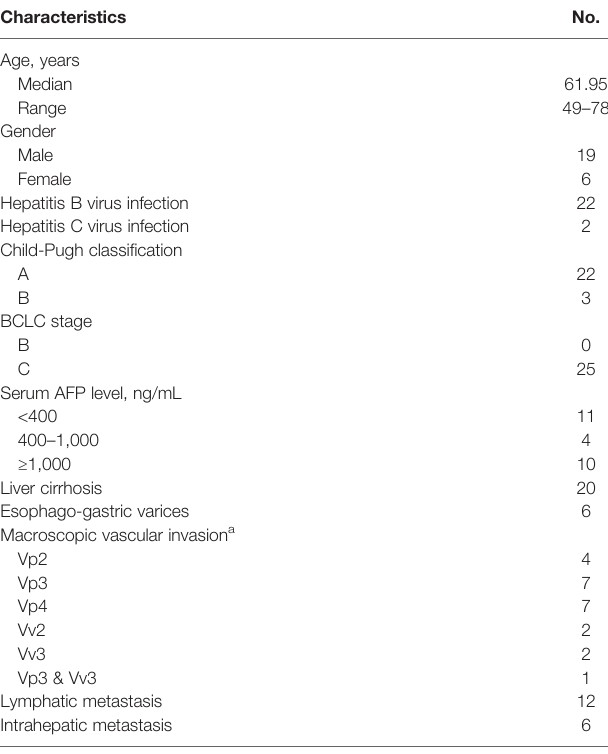
TABLE 1 | Baseline demographic and clinical characteristics (n =